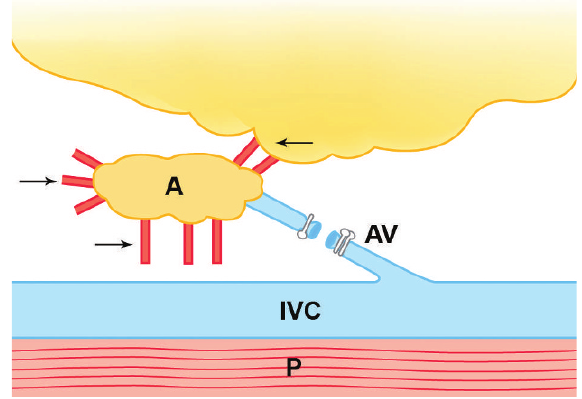
Figure 6 - Left-side retroperitoneoscopic adrenalectomy after adrenal vein section. Adrenal arteries indicated by the arrows. A: adrenal. AO: aorta. AV: adrenal vein. RA: renal artery. RV: